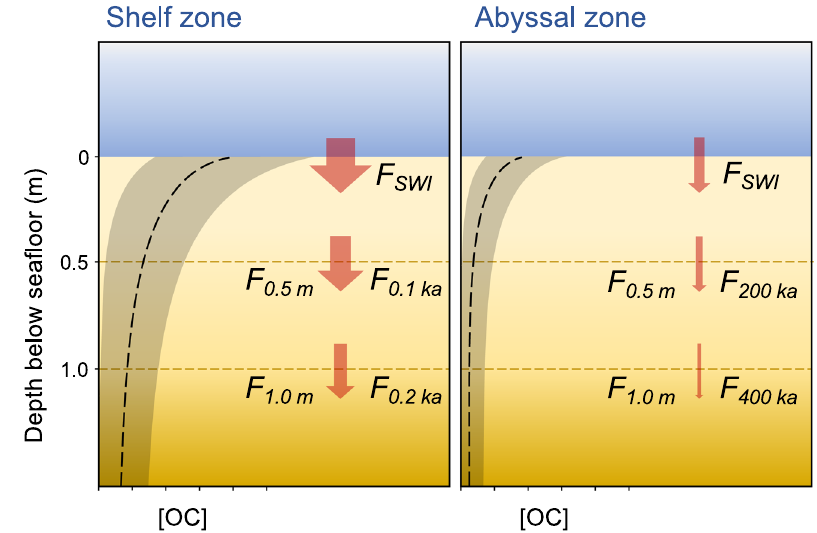
Fig. 1 | Schematic of the deposition and burial of organic carbon (OC) in idea- lized marine sediments in shelf and abyssal zones. The dashed black lines represent illustrative OC concentrations ([OC]) for shelf and abyssal sediments at certain depths and their equivalent (exemplar) ages, and the dark shading repre- sents possible variability in OC concentration between sites. The red arrows indi- cate the fl ux of OC through the sediment water interface ( F SWI ), as well as through speci fi c depth or age layers ( F depth (e.g., F 0.5 m ), and F age (e.g., F 0.1 ka ), respectively).